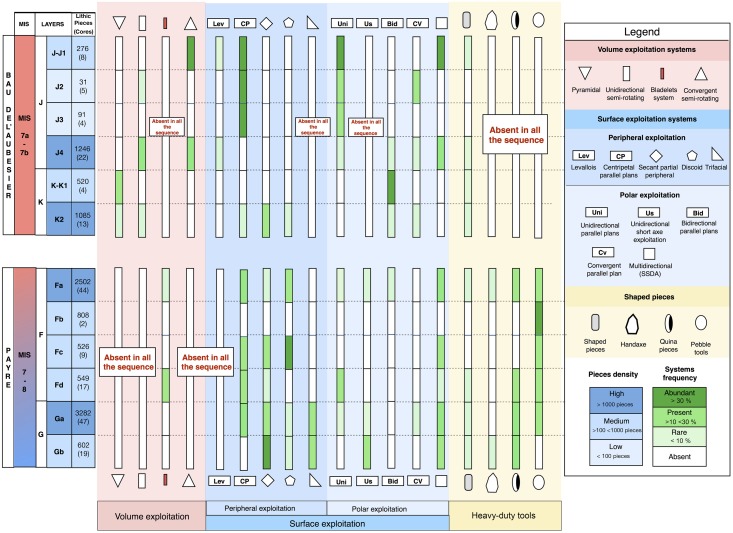
Summary of the reduction processes over the sequences at Payre and the Bau de l’Aubesier.